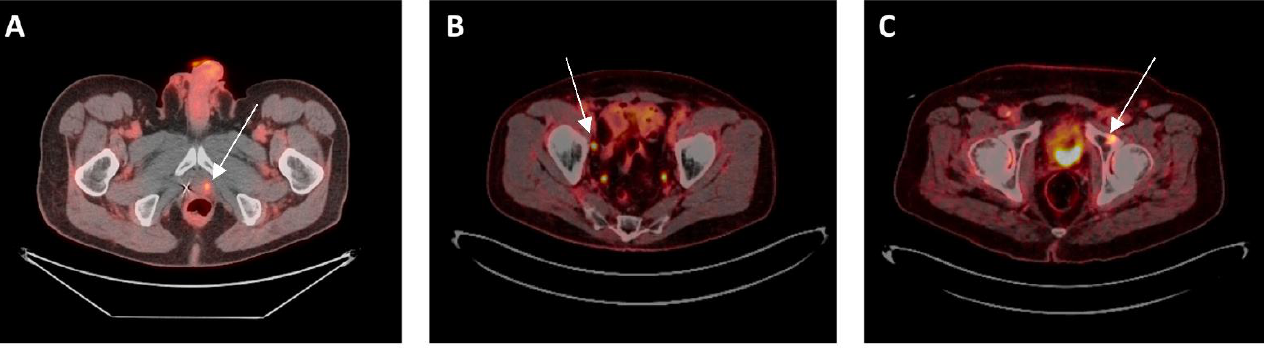
Figure 1. ( A ) Local failure after prior radiotherapy: 72-year-old man with intermediate-risk prostate adenocarcinoma treated with radiation to the prostate with biochemical failure 5 years later. PSMA PET CT showed uptake in left prostate but no regional or distant disease. He received salvage brachytherapy. ( B ) Regional failure after prior prostatectomy: 75-year-old man with high-risk prostate cancer treated with radical prostatectomy, with post-op PSA of 0.17, then treated with pelvic and prostate bed radiation. He again had rising PSA and PSMA PET CT showed uptake in one right pelvic lymph node but no local or distant disease. He received stereotactic radiotherapy to the lymph node. ( C ) Metachronous oligometastasis: 72-year-old man with intermediate-risk prostate adenocarcinoma treated with prostatectomy with undetectable PSA post-op, which then increased a few years later and PSMA PET CT showed uptake in left acetabulum. He received SBRT to the bone lesion without hormone